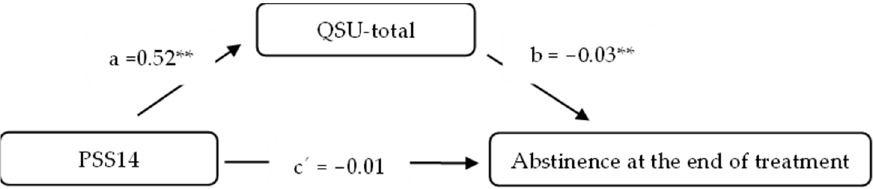
Figure 1. Simple mediation model with QSU-total as a mediator. ** p < 0.01.